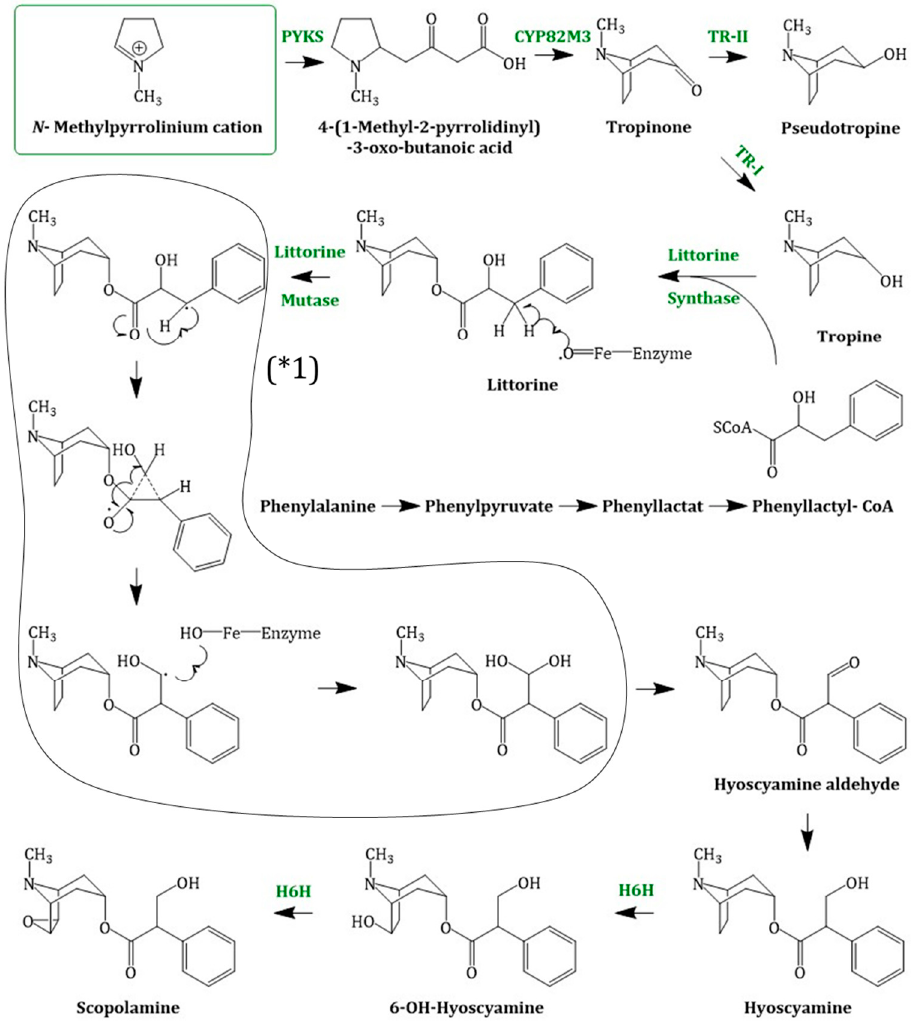
Figure 4. Scopolamine biosynthesis, starting with the N -methylpyrrolinium cation; PYKS = polyketide synthase; CYP82M3 = cytochrome P450 enzyme; TR-I/II = tropinone reductase I/II; littorine synthase